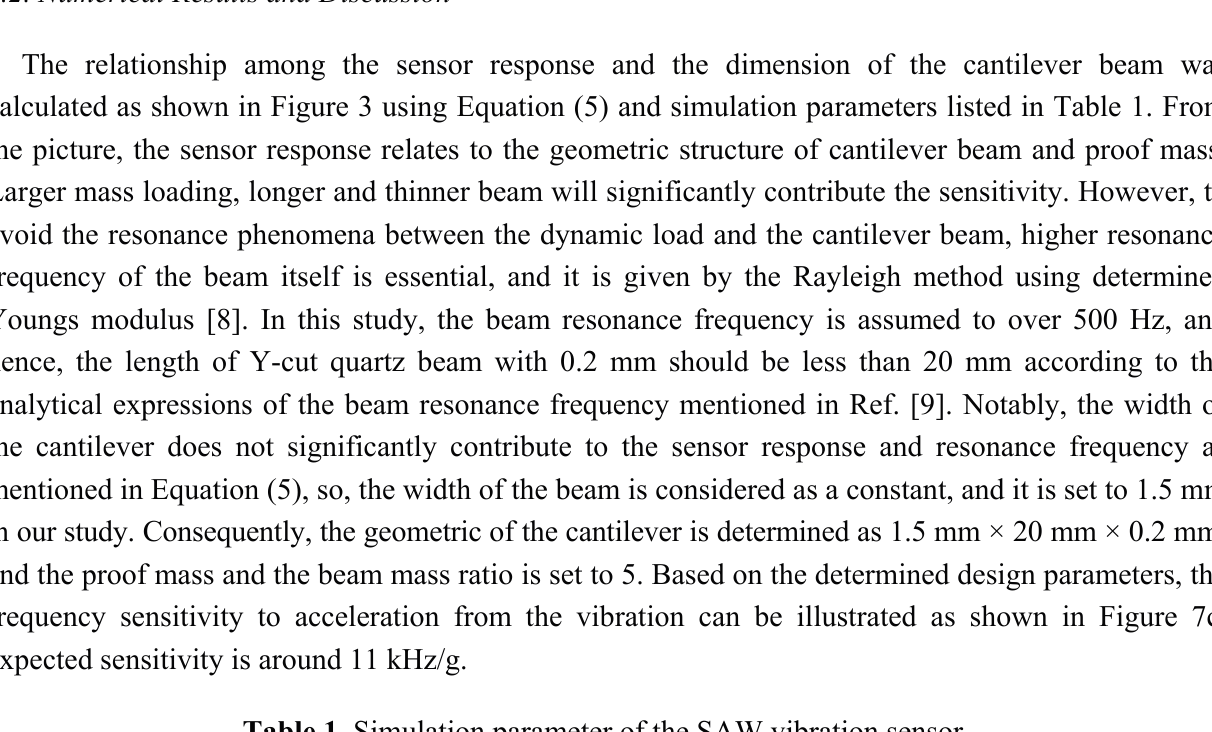
Table 1. Simulation parameter of the SAW vibration sensor.